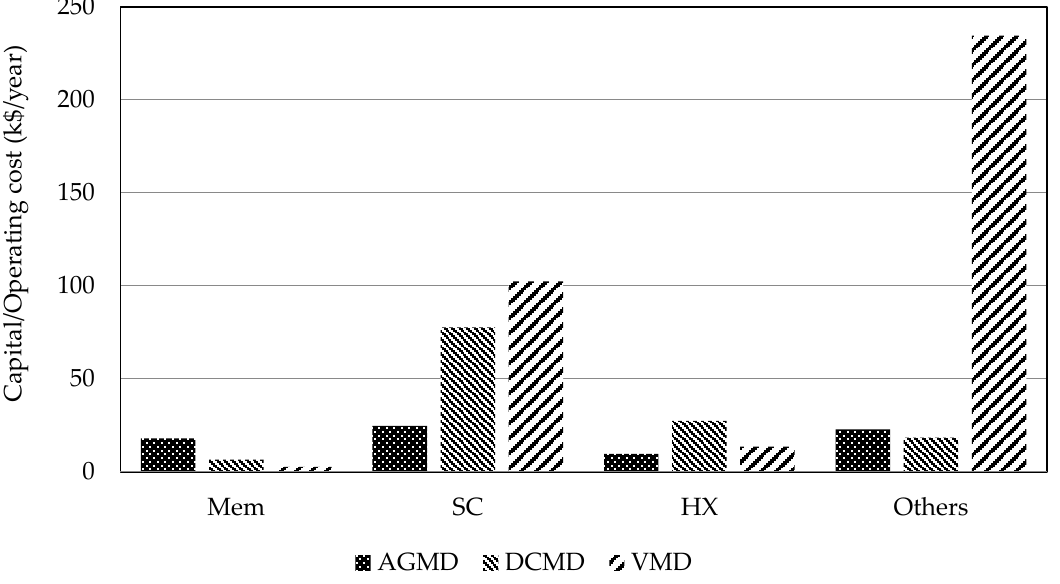
Figure 8. Equipment costs of the optimal SDMD systems for desalination.